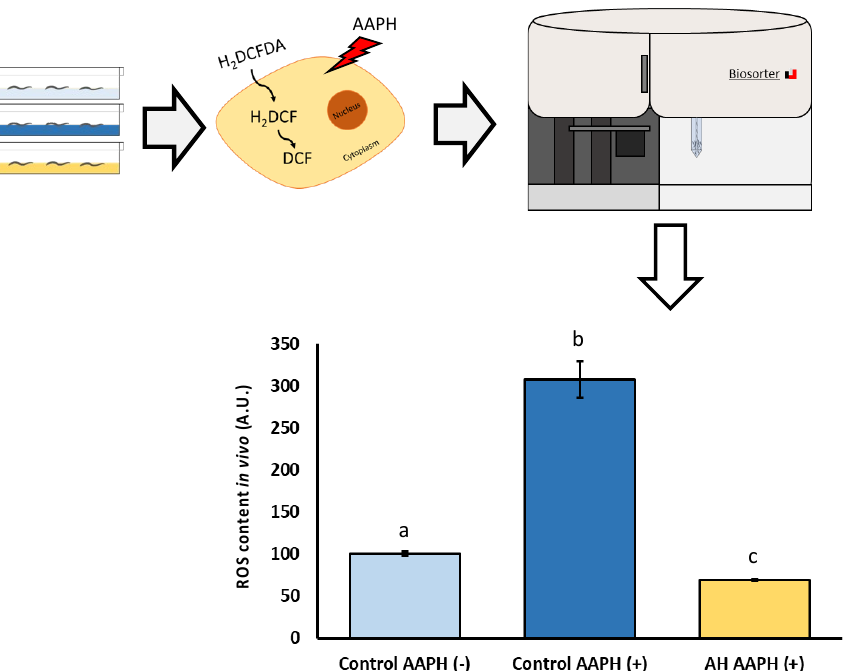
Figure 4. Schematic and analytical representation of the antioxidant analysis of AH against AAPH- induced oxidative stress in C. elegans . Results are mean ± SEM. Different lowercase letters means statistically significant differences ( p < 0.05).